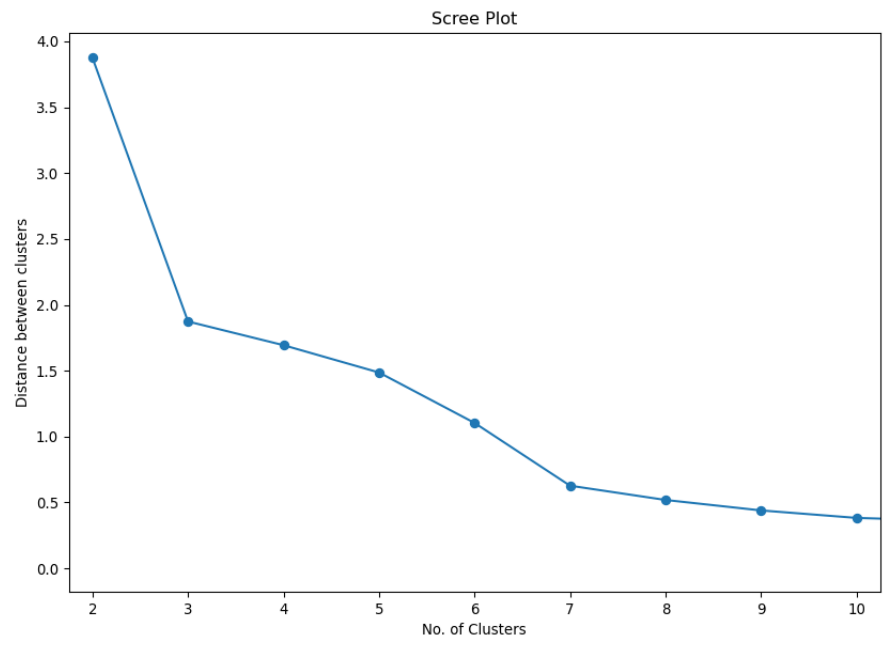
Figure 1. Scree plot for